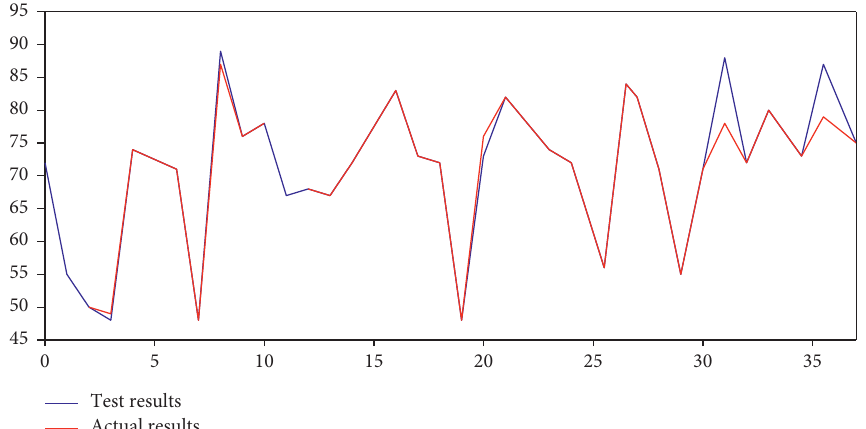
Figure 8: The comparison of the forecast data with the actual TV data.